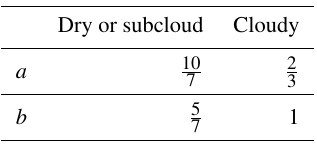
Table 2. Applied a and b coefficients in the vertical velocity equa- tion (Eq.